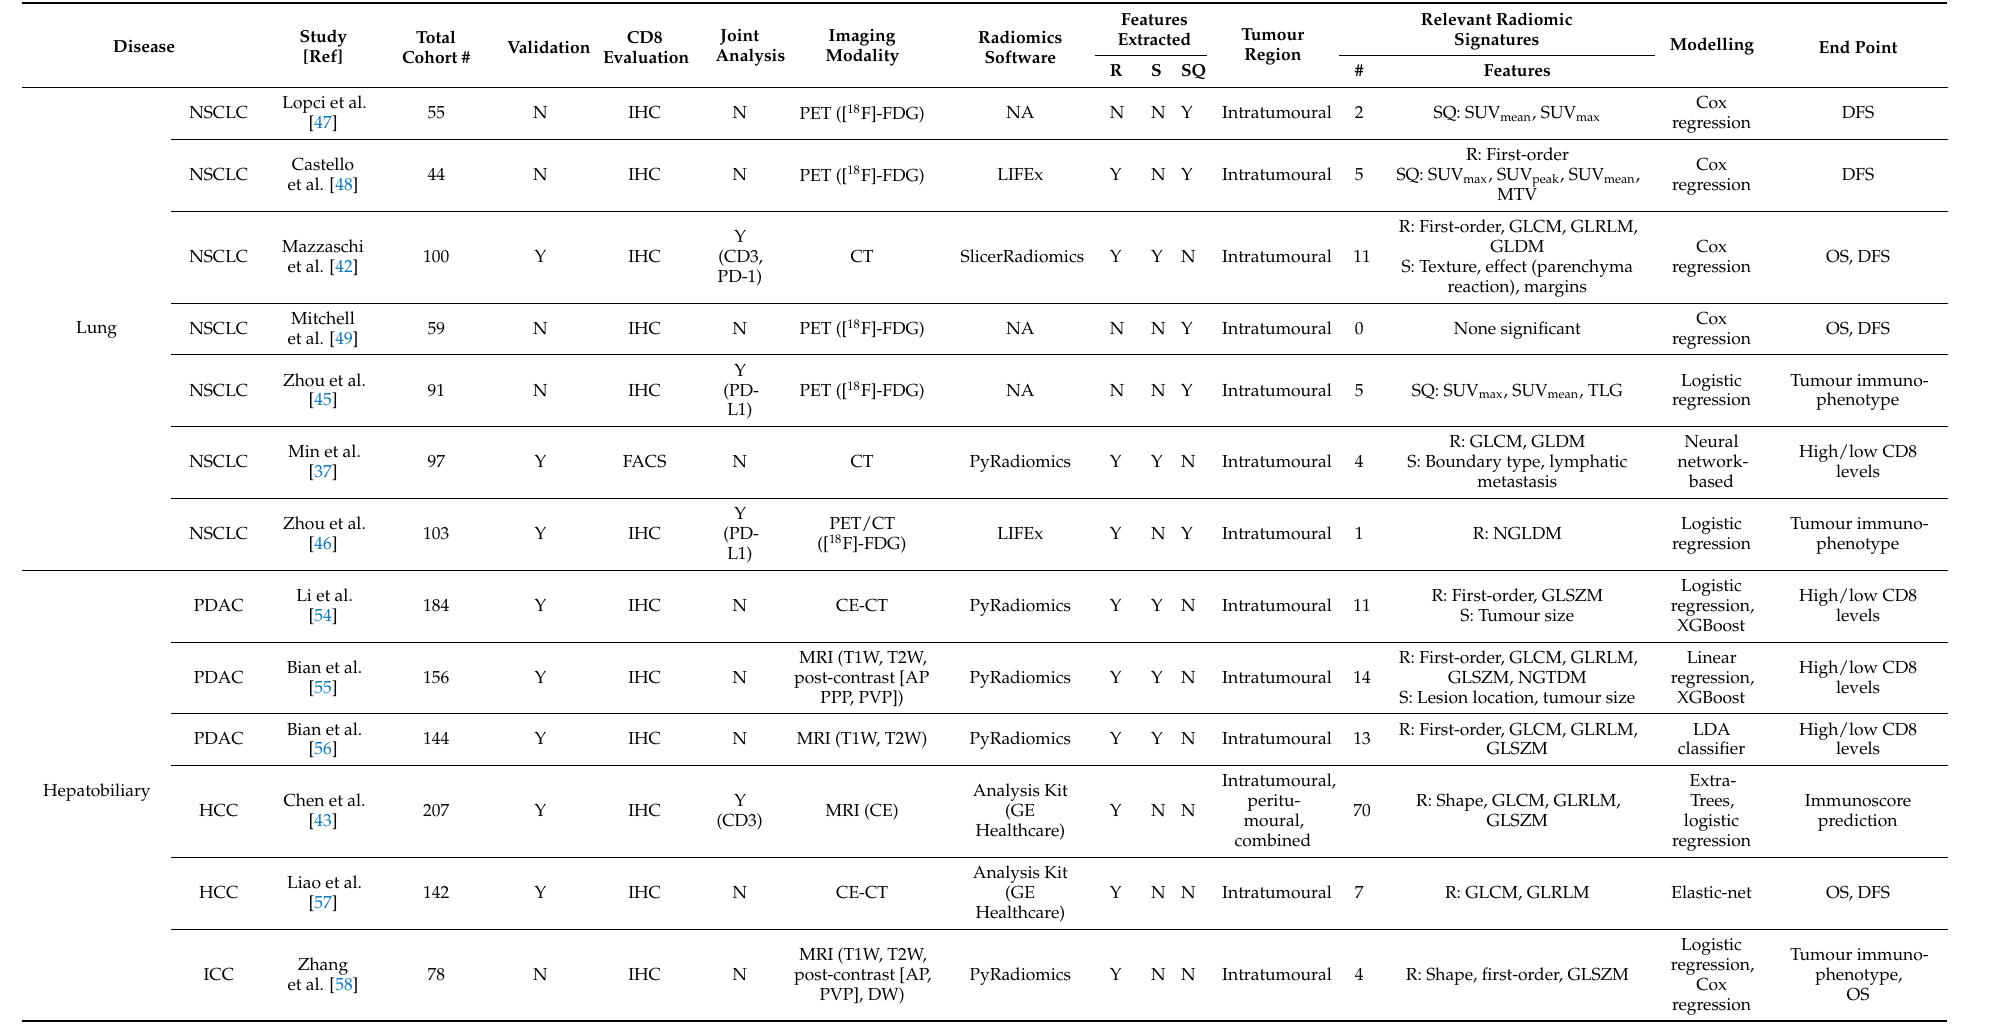
Table 2. Details of included